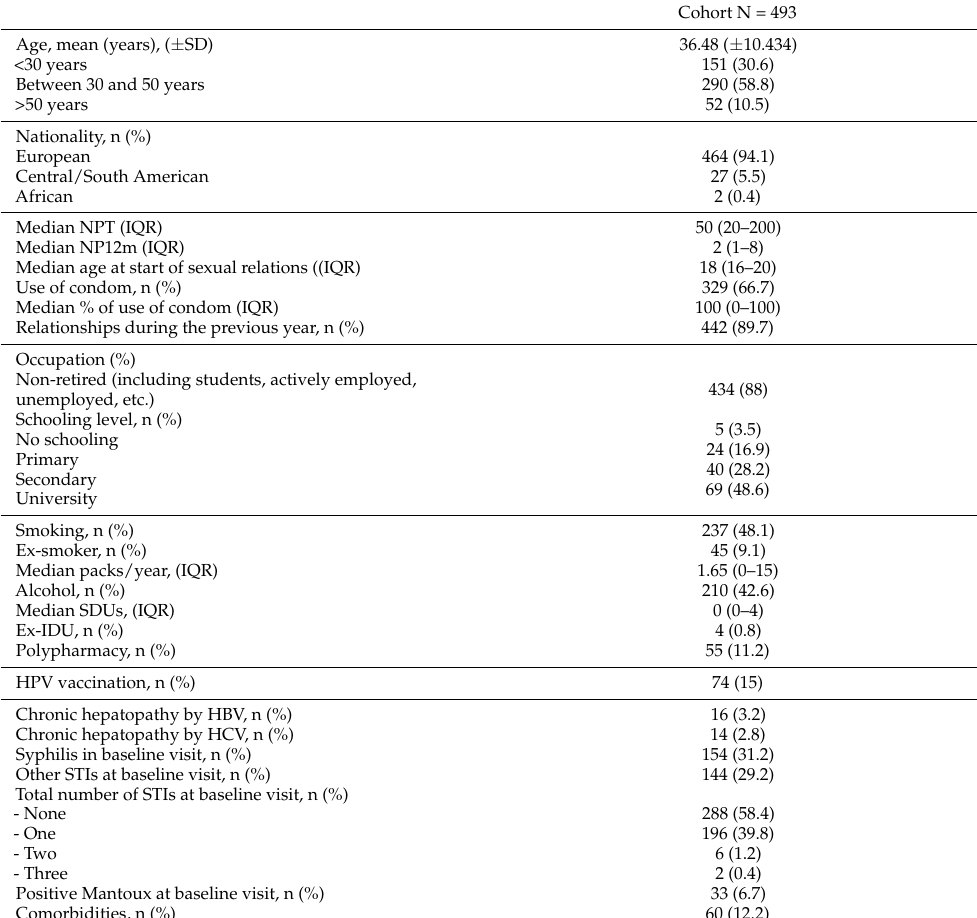
Table 1. Epidemiological characteristics of the